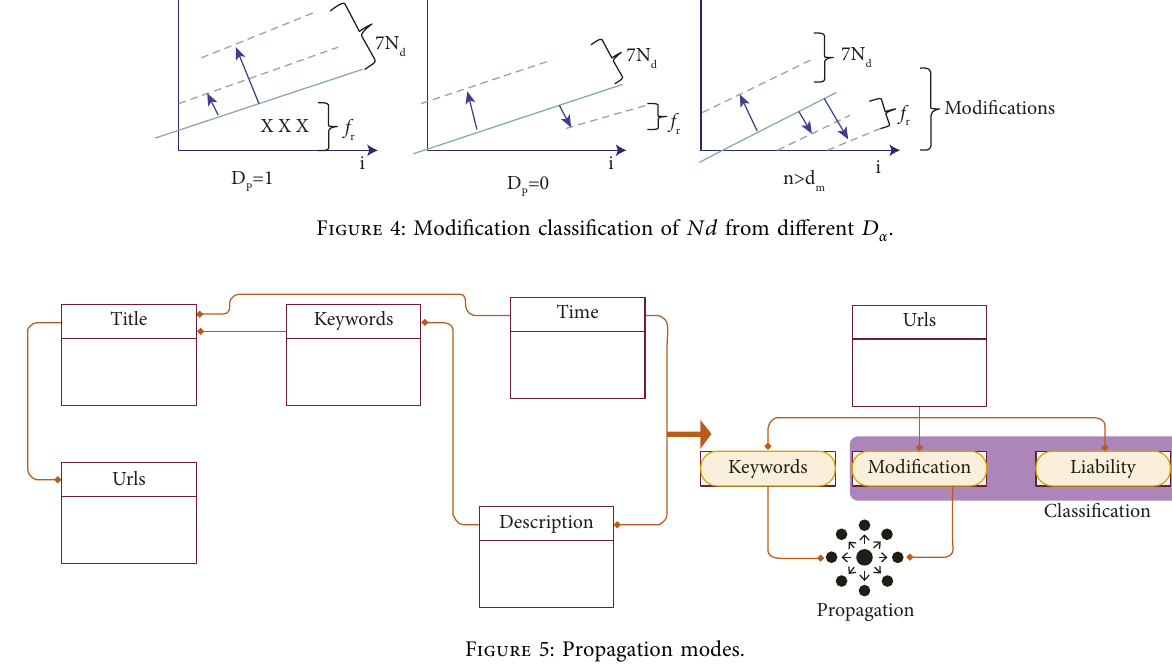
Figure 5: Propagation modes.